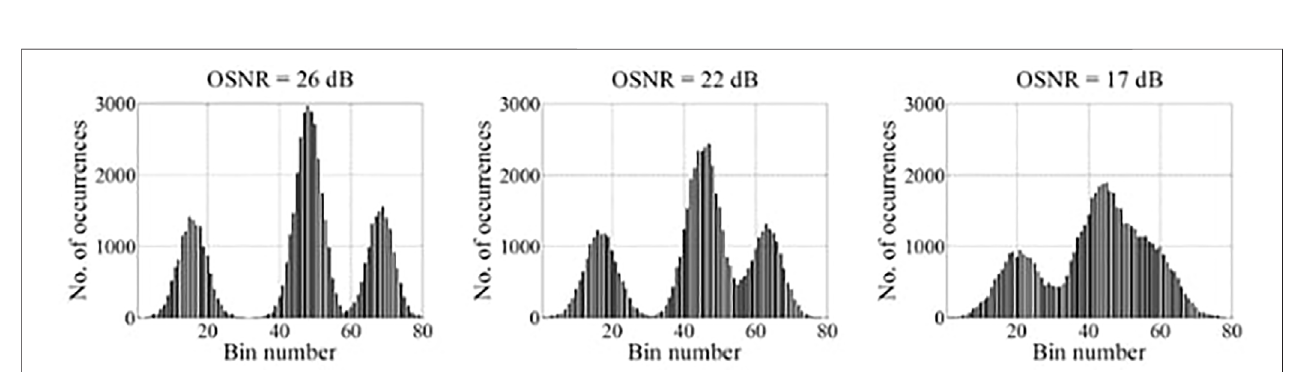
FIGURE 7 | Impact of varying OSNR on the AH of a 16-QAM signal (Khan et al., 2017).